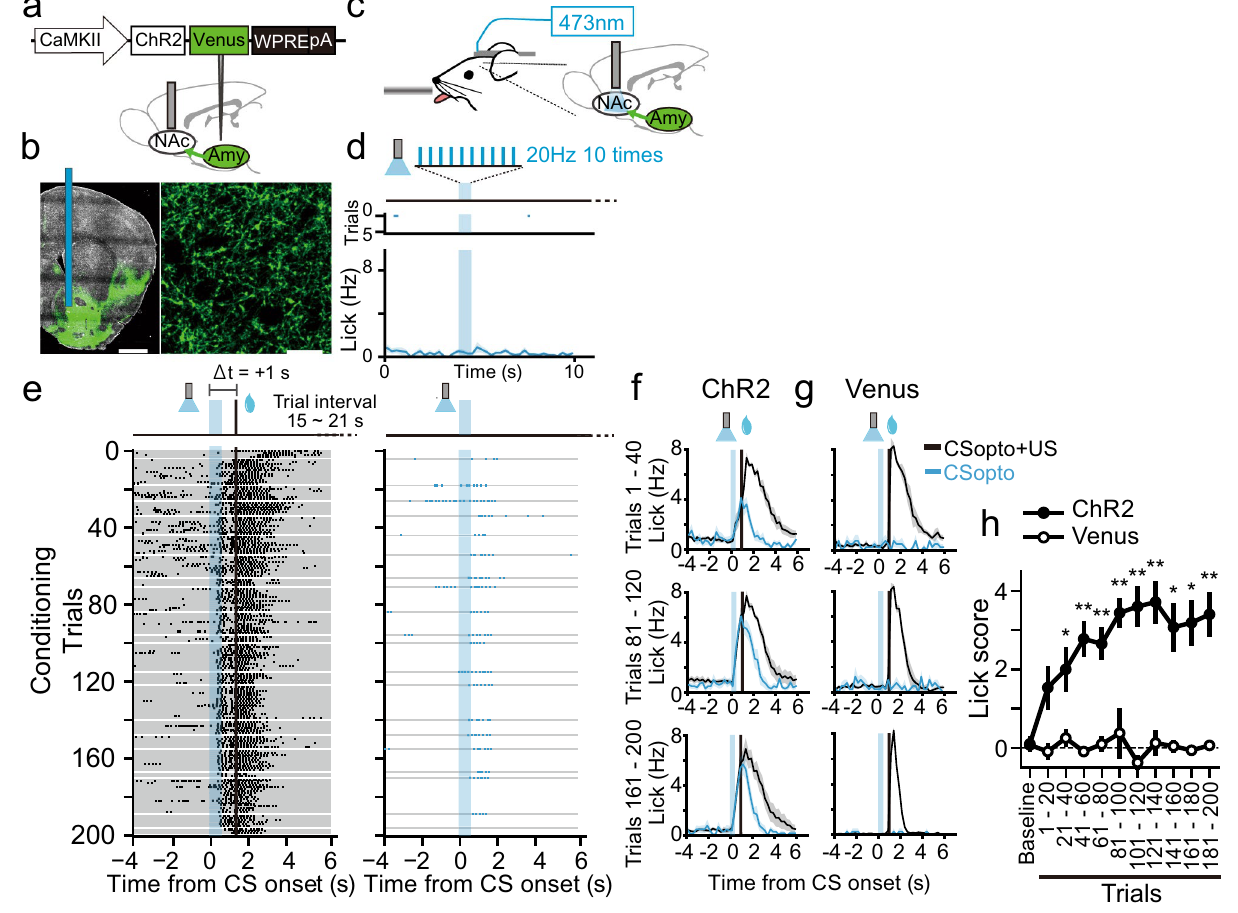
Figure 4. Pavlovian conditioning with CSopto. ( a ) A viral construct and schematic of the AAV injection and optical fibre implantation. ChR2-expressing AAV was injected into the left basolateral amygdala (BLA). An optical cannula (200 μm core) was placed into the left NAc. ( b ) Macroscopic (left) and microscopic (right) confocal images of the green fluorescence of Venus fused with ChR2 in the NAc. A blue vertical bar indicates the tract of the inserted optical cannula. Scale bars indicate 1 mm (left) and 20 μm (right). ( c ) Schematic of the behavioural setup. The optical cannula was connected to a laser (473 nm) by a patch cable. ( d ) Representative licking responses before conditioning in response to ChR2 stimulation (CSopto, 20 Hz, ten times, 5 ms pulse width). Raster plots indicating licking responses from a representative mouse and PSTHs indicating averaged responses over ten mice. Blue shades indicate the period of CSopto presentation. ( e ) Representative licking responses during CSopto conditioning with Δt = + 1 s. The conditioning paradigm was the same as Fig. 1 except that the tone was replaced with CSopto, and the delay was 1 s. Raster plots indicating licking responses from CS + US trials (left) or CS-only trials (right). Each gray bar indicates a single trial. Black vertical bars indicate the onset of US presentation. ( f , g ) Averaged PSTHs for the licking responses in the first 20% of the trials (1–40, upper), the third 20% of the trials (81–120, middle), or the last 20% of the trials (161–200, bottom) for each of the CS + US trials (black trace) or the CS-only trials (blue trace) from mice injected with ChR2 ( f , n = 10) or Venus ( g , n = 4). Shadows indicate SEM. ( h ) Lick scores (“Methods”) plotted against time course for the ChR2 mice ( n = 7) and Venus mice ( n = 4). Kruskal–Wallis test. * P < 0.05, ** P < 0.01. Error bars indicate